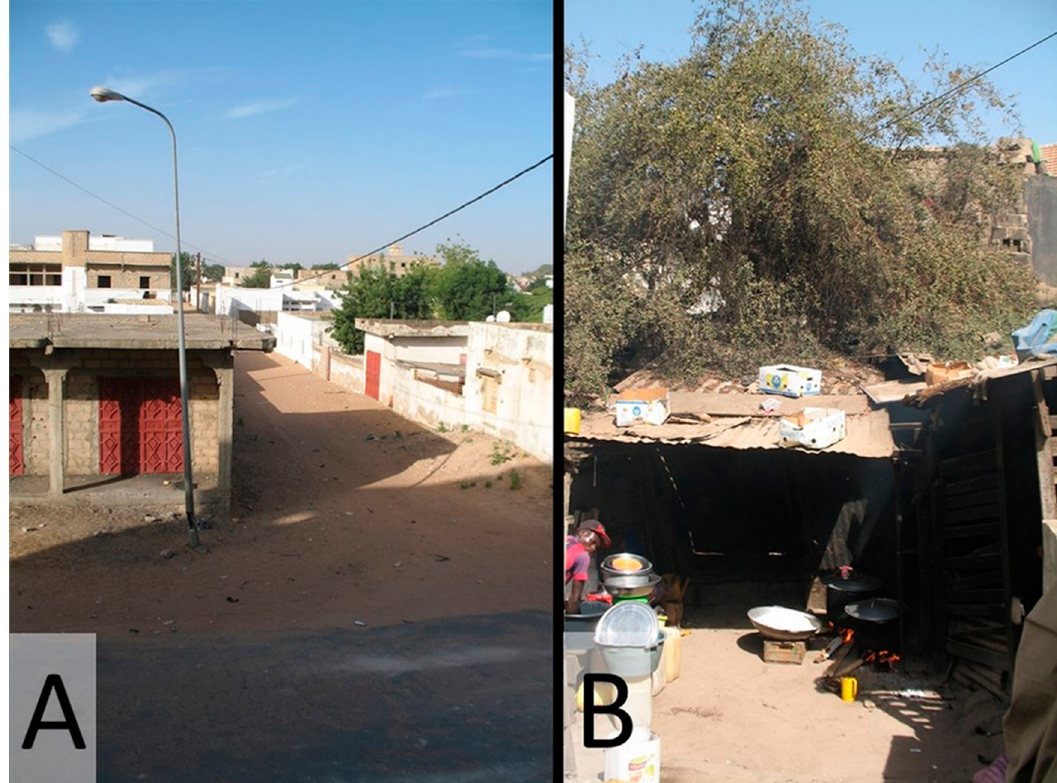
Figure 2. ( A ) As informal space beyond the state’s surveillance, the holy city of Touba, Senegal, is administered by the Sufi leaders of the Mur ī diyya without street names or numbered units, but according to an alternative organizing rationale; ( B ) downtown Dakar, Senegal. Thieudéme, a precolonial Lebou toponym, has managed to survive in space and time within the formerly French grid, in spite of repeated colonial evictions (author’s photos).